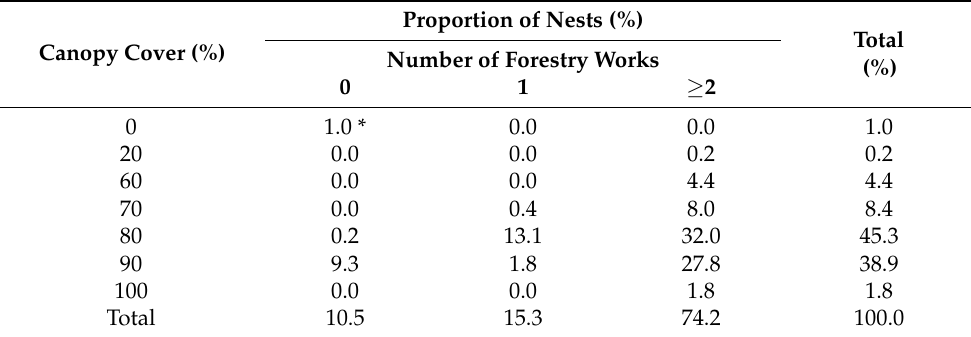
Table A4. Distribution of RWA in 2018 according to stand canopy cover and number of forestry works carried out in the last decades within the stands with ant nests.